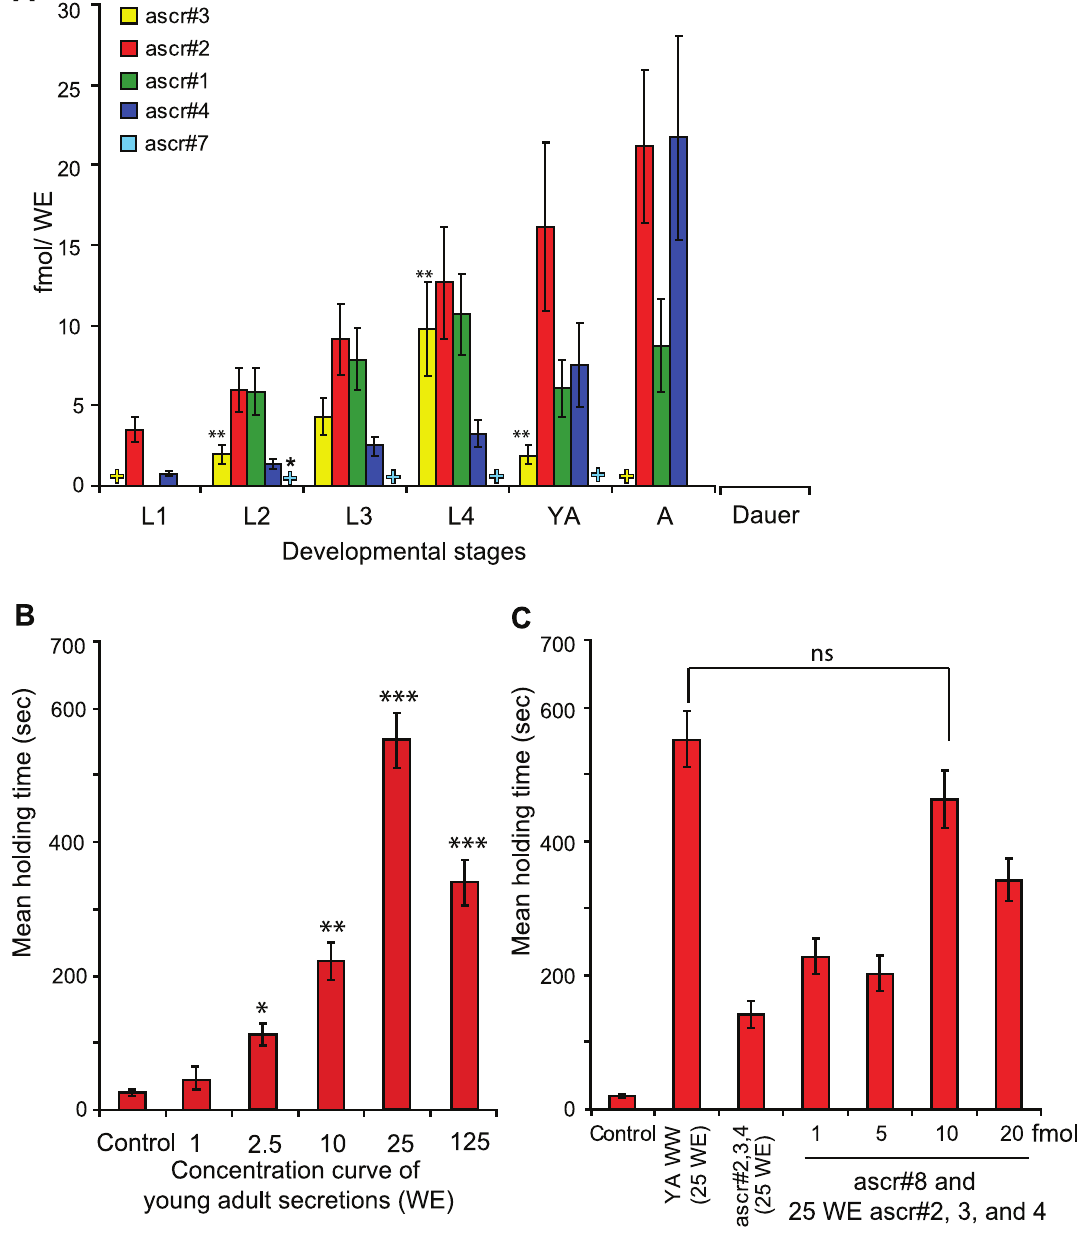
Figure 2. Ascaroside secretion of C.elegans at different developmental stages. (A) Concentrations of ascr # 1, ascr # 2, ascr # 3, and ascr # 4 in WW samples during development. One WE is defined as the amount of material released from one worm within 1 h. L1, L2, L3 and L4, larval stages; YA, young adult; A, adults with 10–15 eggs. For the columns labeled ‘‘Dauer’’, 7 day old (163 h) dauer larvae were used. The figure represents the mean of four experiments and error bars, s.e.m. **P , 0.05 (L4 to L2 and YA), unpaired t -test. + , detectable but not quantifiable and + *emphasize that ascr # 7 is only quantifiable in L2 WW (0.5 6 0.08 fmol/WE). The ascr # 4 concentrations were estimated using the ascr # 2 concentration curve due to lack of synthetic ascr # 4. Ascr # 1 concentrations were estimated using its unsaturated analog, ascr # 7, as a standard. (B) Concentration curve for mating activity of YA WW, n $ 30 worms for each histogram. *P , 0.05, **P , 0.01, *** P , 0.0001, using one-factor ANOVA with Dunnett’s post-test. Error bars are s.e.m. (C) Reconstitution of male attraction activity with synthetic pheromone blend, n $ 30 animals for each histogram. Based on LC-MS quantification, the amounts of the three main pheromone components in 25 WE were 537 fmol for ascr # 2, 55 fmol for ascr # 3 and 789 fmol for ascr # 4. n $ 30 animals for each histogram. However, the full synthetic blend consisted of ascr # 2, ascr # 3, ascr # 4 and ascr # 8. There was no significant difference in mating activity between YA WW (25 W.E.) and the synthetic blend when 10 fmol of ascr # 8 was added to the 25 WE for ascr # 2, ascr # 3, and ascr # 4, P , 0.05, unpaired t -test. Error bars are s.e.m. doi:10.1371/journal.pone.0017804.g002 stronger synergistic attraction was achieved by using 20 fmol of preparation with similar ascaroside concentrations. Following the ascr # 3 in combination with ascr # 2 and ascr # 4 [8]. This identification of ascr # 8 via NMR-spectroscopic methods from synthetic blend was still less active than a natural YA WW large liquid cultures [10], less than 1 fmol/WE of ascr # 8 was